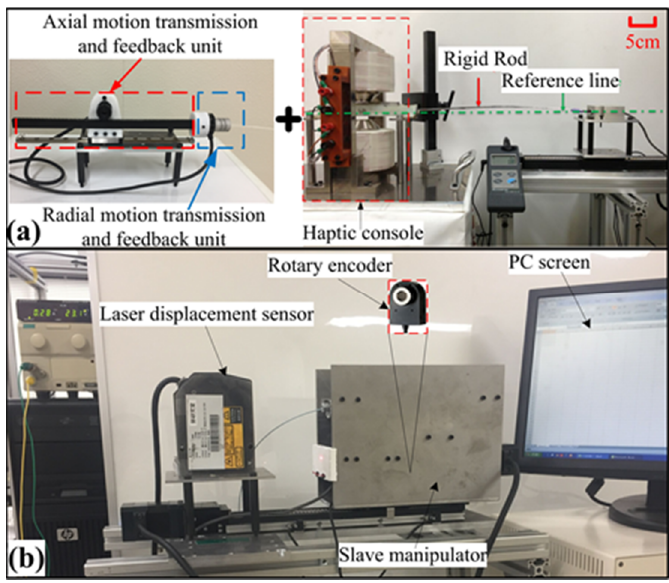
Figure 8. ( a ) The motion input setup on the master side. ( b ) The motion detection setup on the slave side.